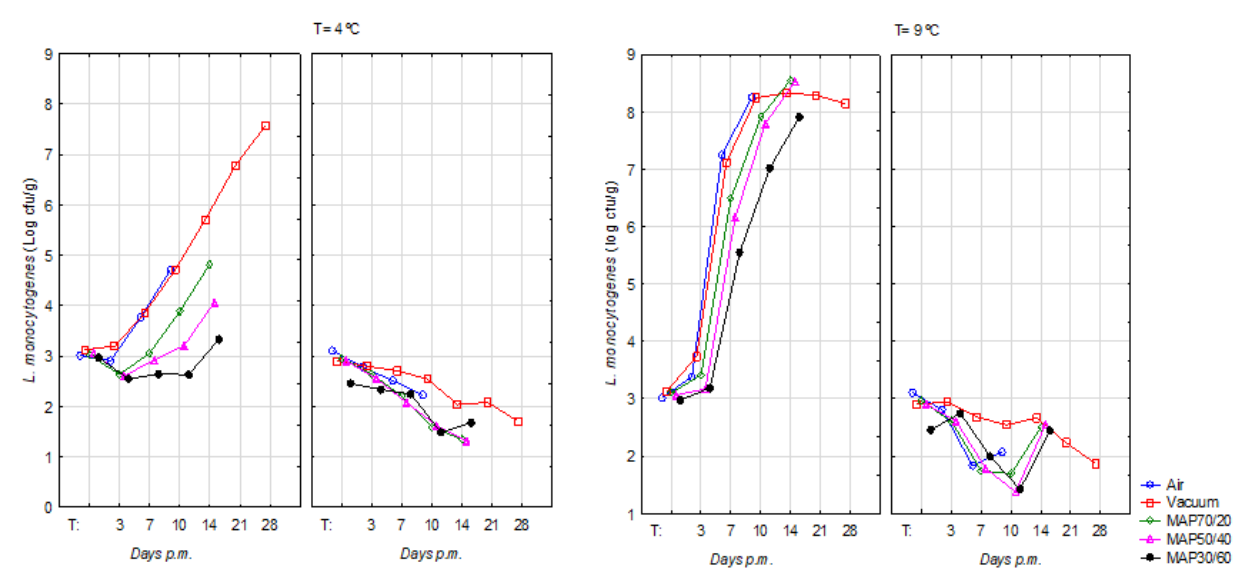
Figure 2. Evolution of L. monocytogenes levels (log UFC/g) on DFD (left) and Normal (right) beef stored at 4 °C and at 9 °C, packed in air, vacuum and MAPs -O 2 /CO 2 /N 2 - 70/20/10 (MAP70/20), 50/40/10 (MAP50/40), 30/60/10 (MAP30/60), during time of storage.